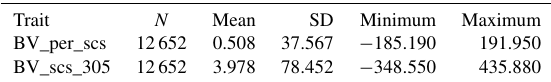
Table 3. Descriptive statistics for BV of lactation persistency and BVs of somatic cell